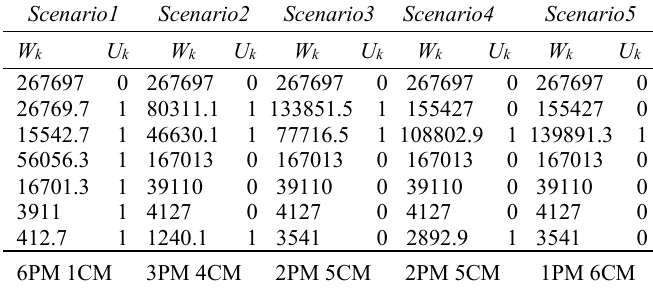
Table 2. Failure data.